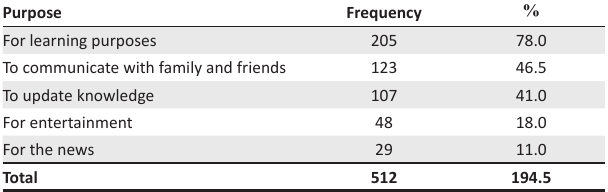
TABLE 3: The purpose of learners’ Internet use: Multiple responses.